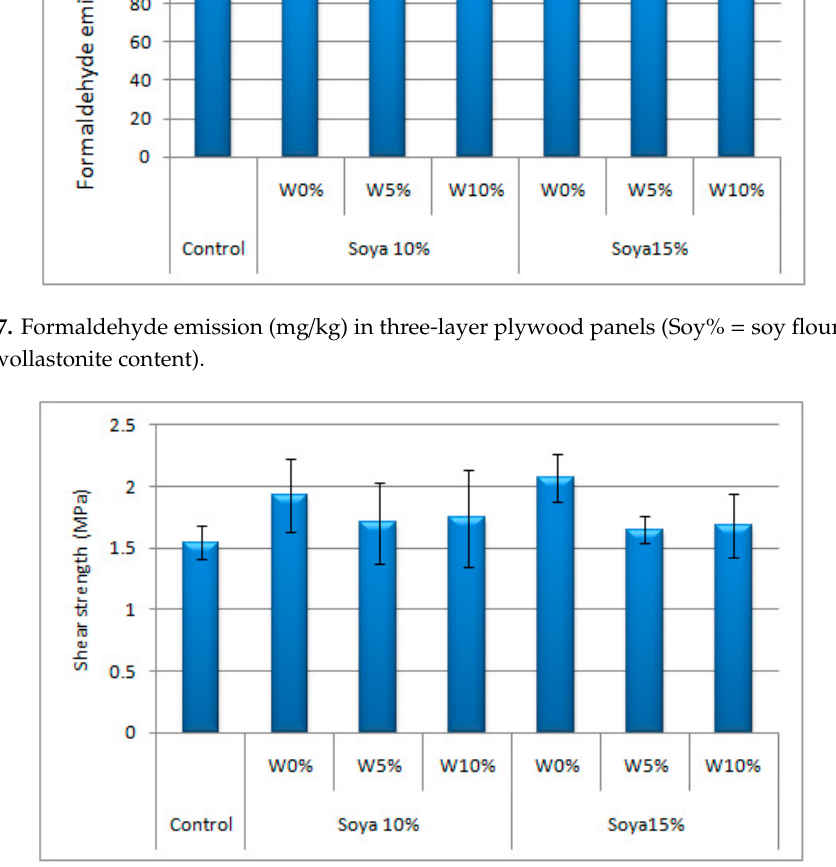
Figure 8. Shear strength (MPa) in three-layer plywood panels (Soy% = soy flour content; W% = wollastonite content).